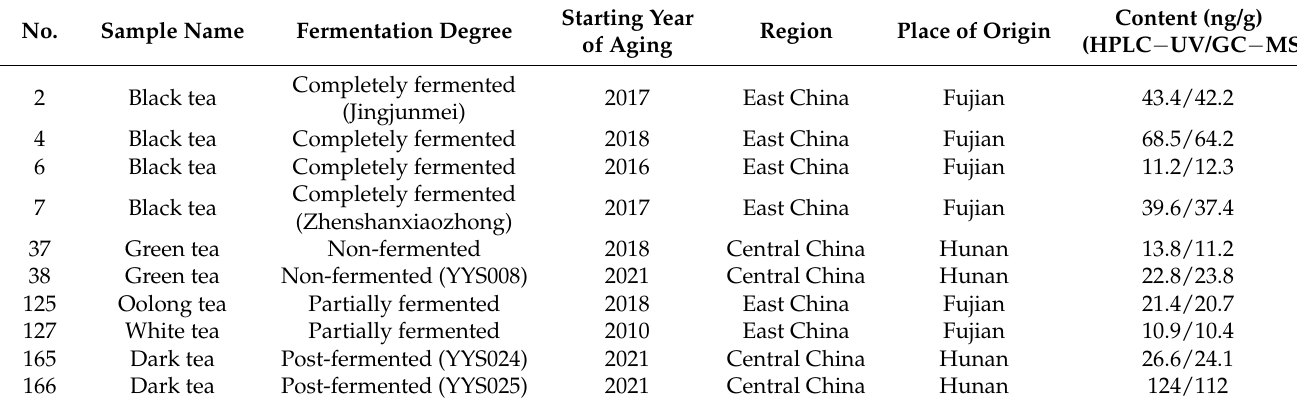
Table 5. Results of the 10 tea products with a PAT concentration higher than 10